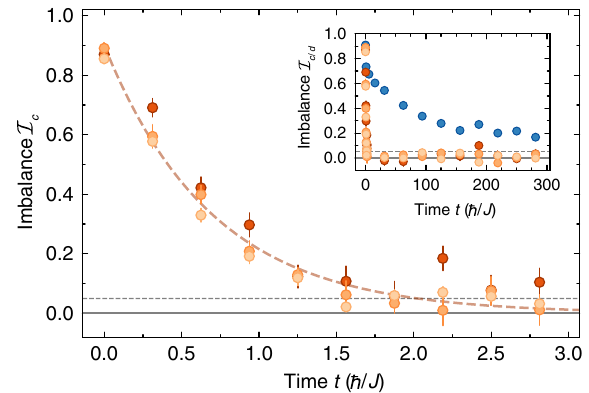
FIG. 4. Imbalance dynamics of the clean component. Evolution of the clean component imbalance I c for three different atom numbers of the clean component ( N c ¼ 120 in light orange, N 60 in orange, and N 20 in dark orange). The dashed- c ¼ c ¼ line curve is an exponential fit with time constant of 0 . 7 τ . All bath sizes result in a similar behavior, with the imbalance vanishing in few tunneling times. The inset shows the long-time evolution of the clean component compared with the dynamics of the dirty component in the N c ¼ 0 case, highlighting the strong difference in the timescales. The horizontal dashed gray lines indicate the typical statistical threshold at which the imbalance is compatible with zero. The error bars represent 1 standard deviation of the